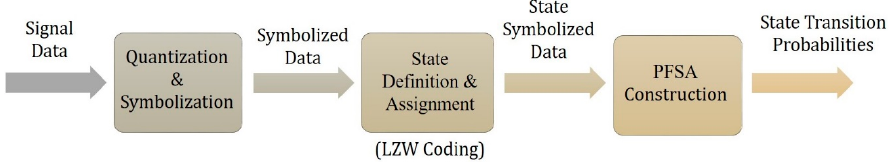
Figure 1. Flowchart of the Lempel–Ziv–Welch (LZW)-coded probabilistic finite state automata (PFSA) method.